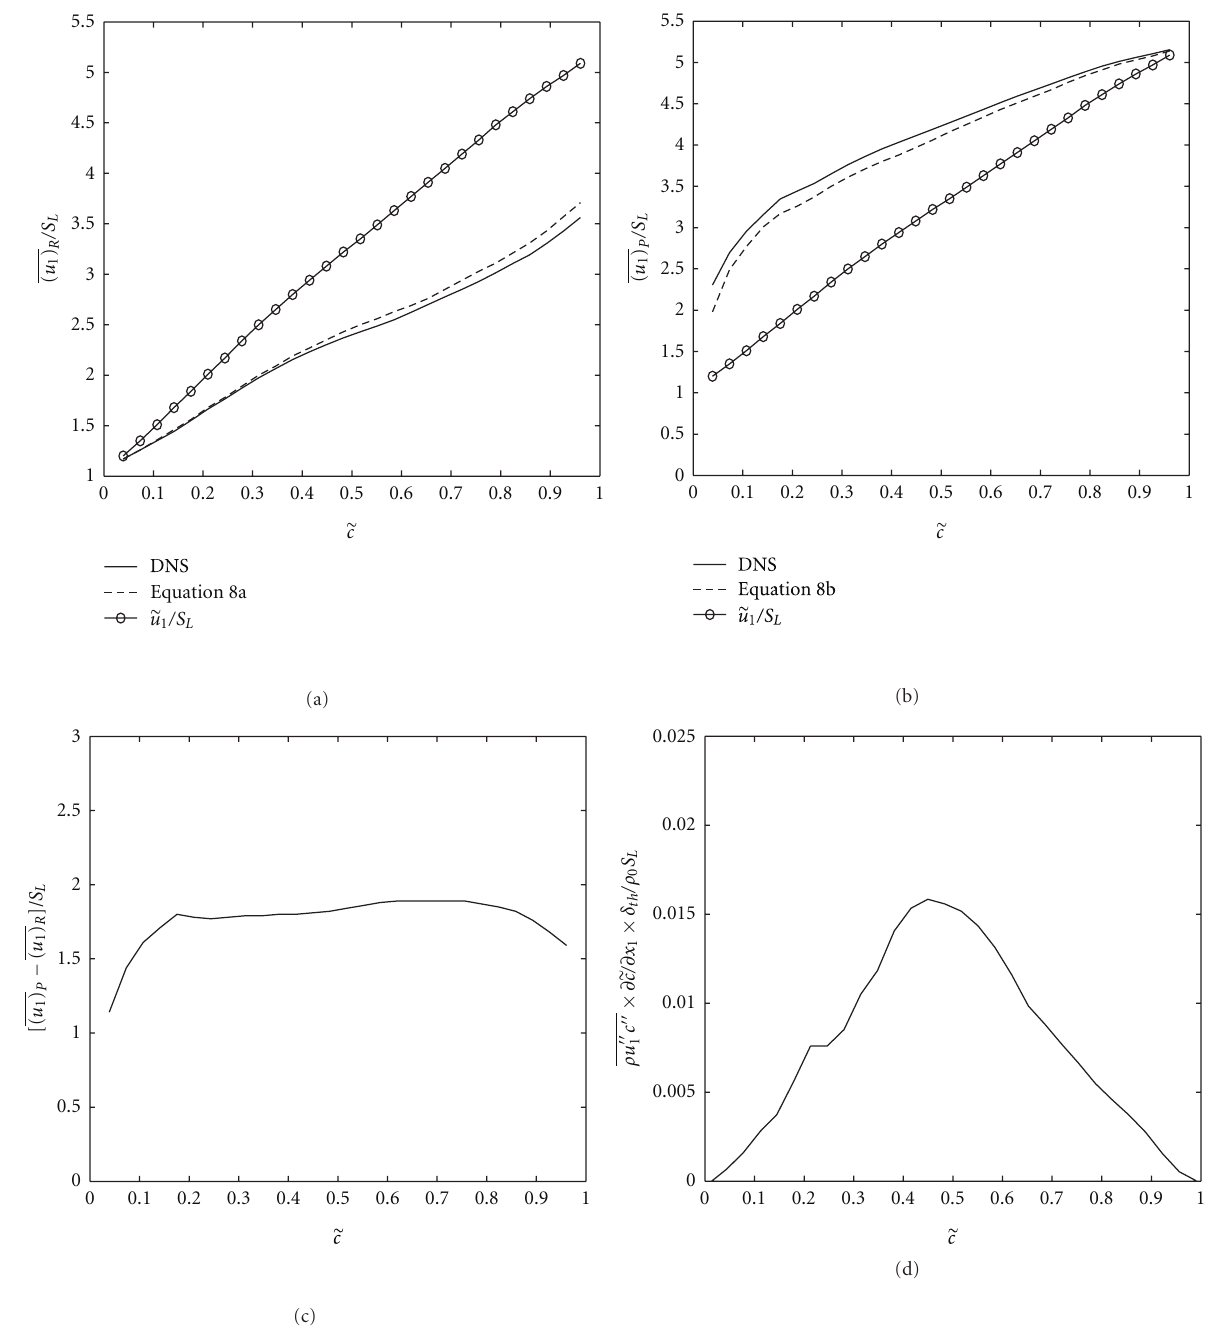
Figure 2: (a) Variations ( u 1 ) (cid:2) u (cid:2) c across the flame brush along with the predictions of (8b). Variations of (c) [( u 1 /S L with with (cid:2) c across the flame